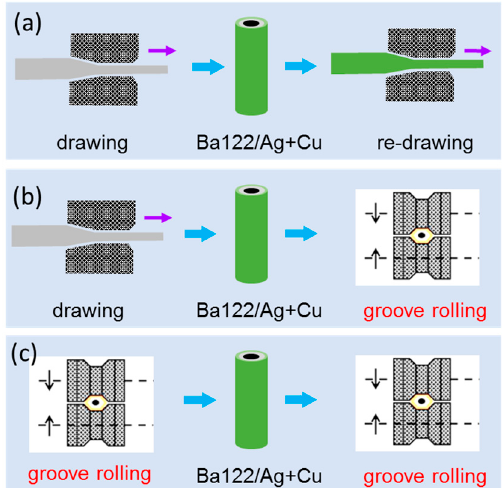
Figure 14. The introduction of groove rolling in (Ba,K)Fe 2 As 2 wires. ( a ) Drawing is applied before and after a Ag wire is put into the Cu tube; ( b ) drawing and groove rolling are applied before and after a Ag wire is put into the Cu tube; ( c ) groove rolling is applied before and after a Ag wire is put into the Cu tube.